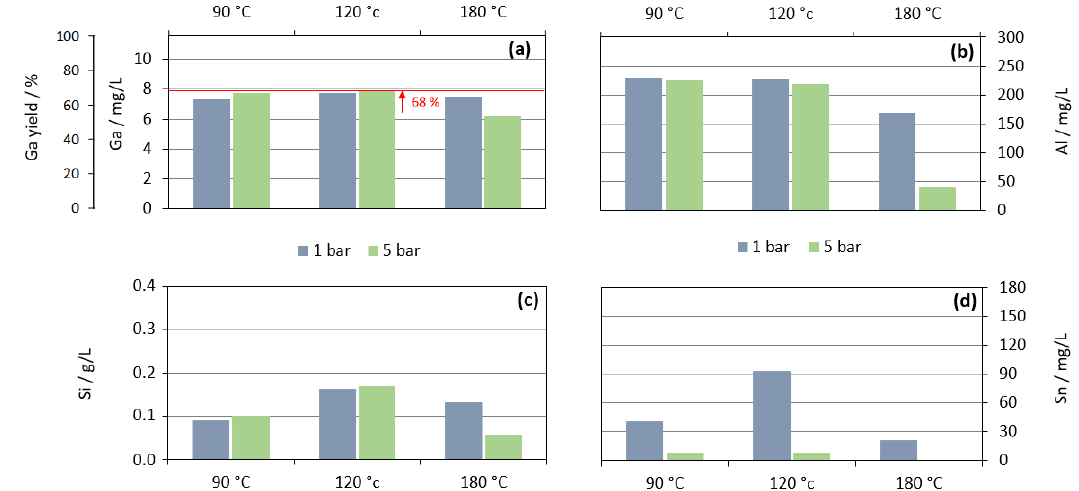
Figure 13. The elemental concentrations of gallium ( a ), aluminum ( b ), silicon ( c ), and tin ( d ) in the liquor after trial series C; the (maximum) gallium yield is indicated additionally; constants: 2 g/L NaOH, 1 h, 800 rpm, S/L = 0.1.